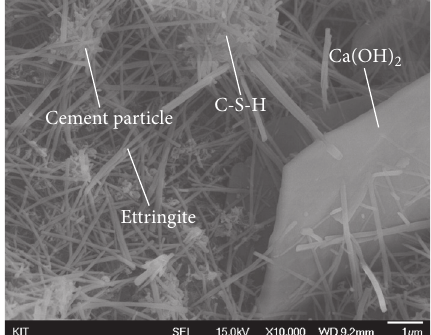
Figure 9: SEM image of OPC (3 days).